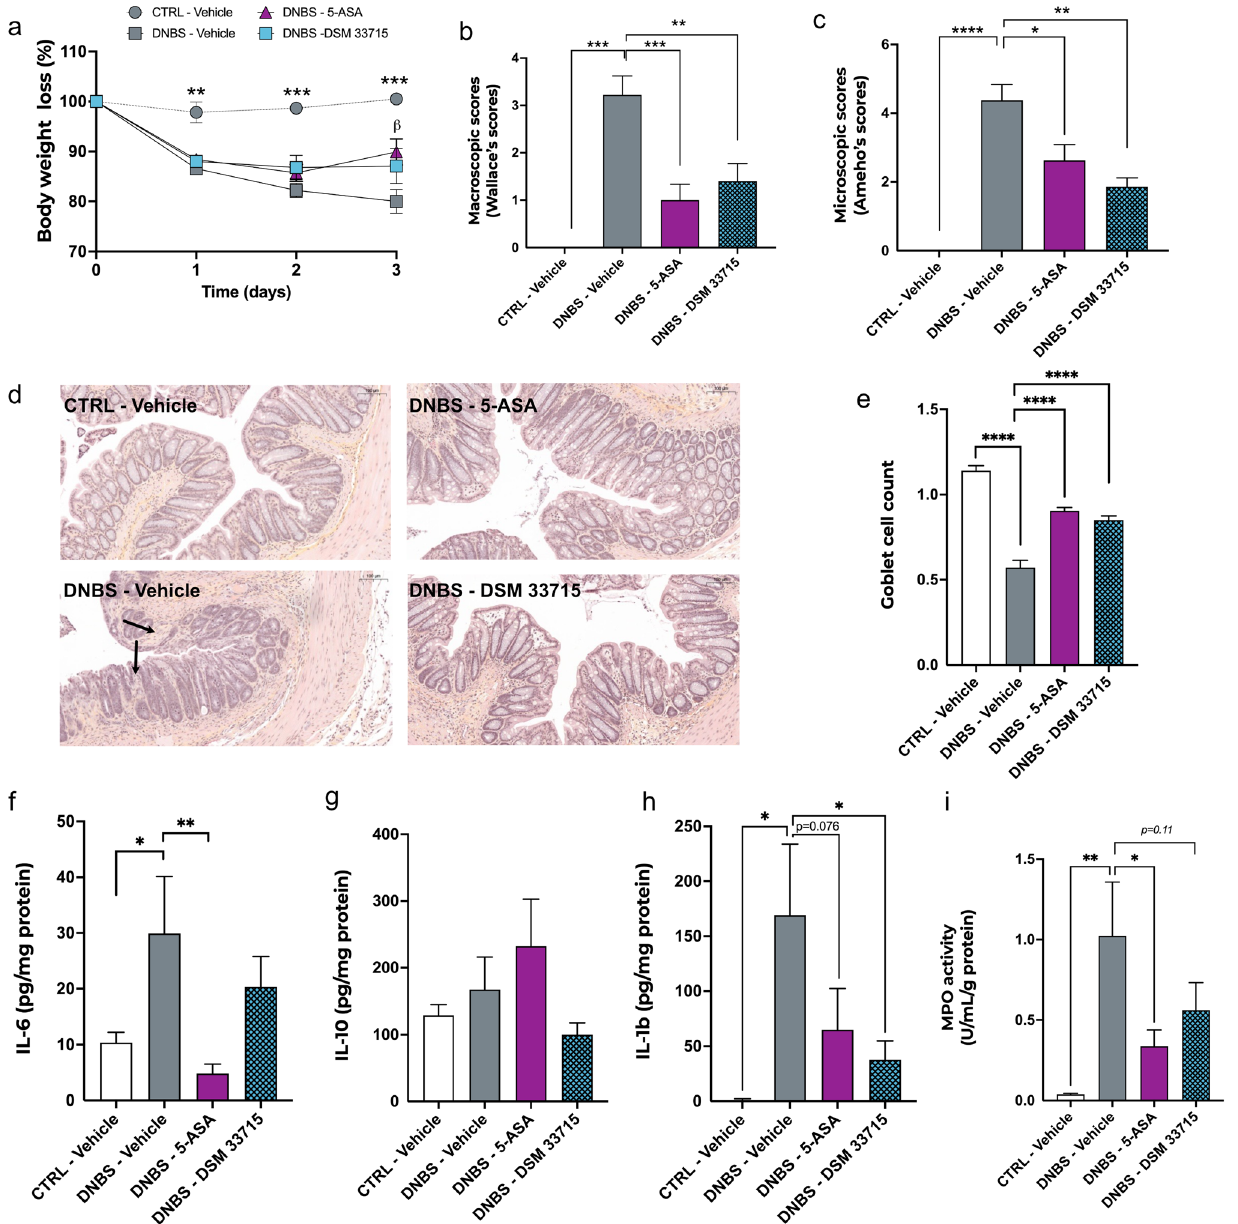
Figure 6. C. minuta DSM 33715 ( C. min 22) protects against DNBS-induced colitis in mice. Animals received either C. minuta DSM 33715 ( C. min 22) (10 9 CFU/day), the vehicle, or 5-ASA (150 mg/kg/day) daily for 14 days by oral gavage prior intra-rectal DNBS injection (minimum n = 6 per group). The positive control 5-ASA was administered on the day of colitis induction and for the following 3 days of recovery period. Body weight loss was monitored for 3 days post DNBS injection ( a ). The macroscopic ( b ) and microscopic ( c ) scores were recorded post mortem . Evaluation of the colonic epithelial structure ( d ). Arrows indicate strong alterations of the epithelial surface. Goblet cell number per crypt ( e ). Colonic levels of IL-6 ( f ), IL-10 ( g ) and IL-1β ( h ) cytokines and MPO activity ( i ). Statistics : ( a ) Repeated measure mixed effects model followed by Dunnet’s multiple comparison test where the DNBS-vehicle group was chosen as control; ( b , c ) Kruskal–Wallis followed multiple comparison; ( e – i ) One-way ANOVA followed by multiple comparison. *p < 0.05, **p < 0.01, ***p < 0.001, ****p < 0.0001 (minimum n = 6 per